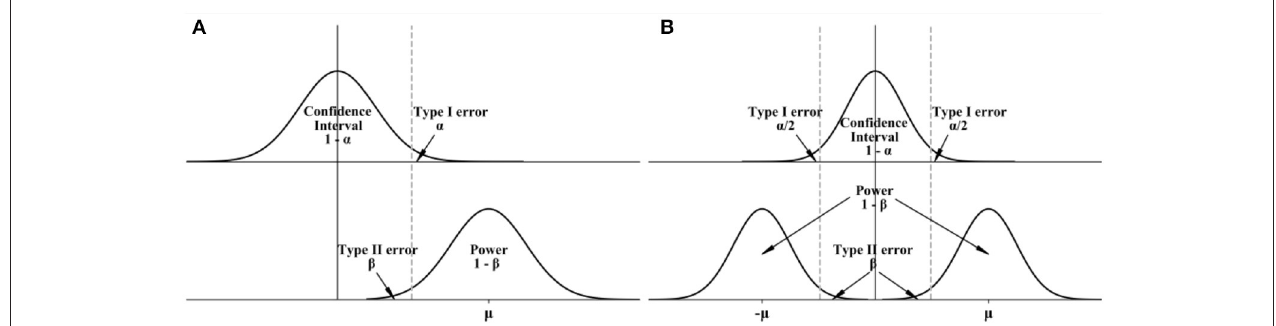
FIGURE 2 | Relationship of confidence interval, critical region and power for (A) one-tailed test and (B) two-tailed